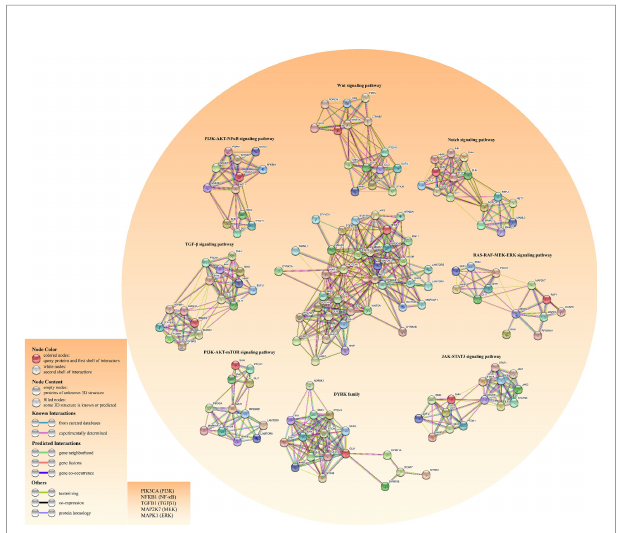
FIGURE 3 | Construction of the crosstalk network for both HH pathway and other cancer-related pathways using the STRING database. The left bottom literal statements are the alternative names of the